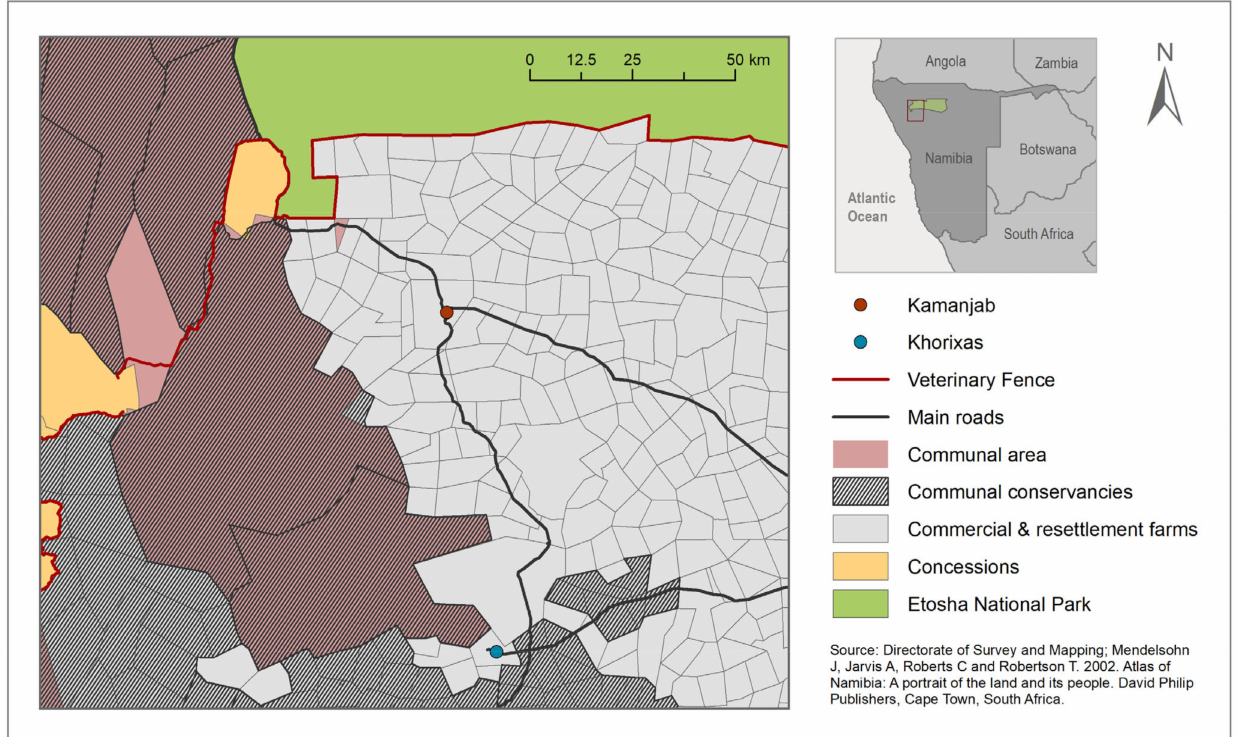
Figure 1. Study area in the northwest of Namibia, south of the Etosha National Park. The map indicates the different land use types, key agglomerations and infrastructural